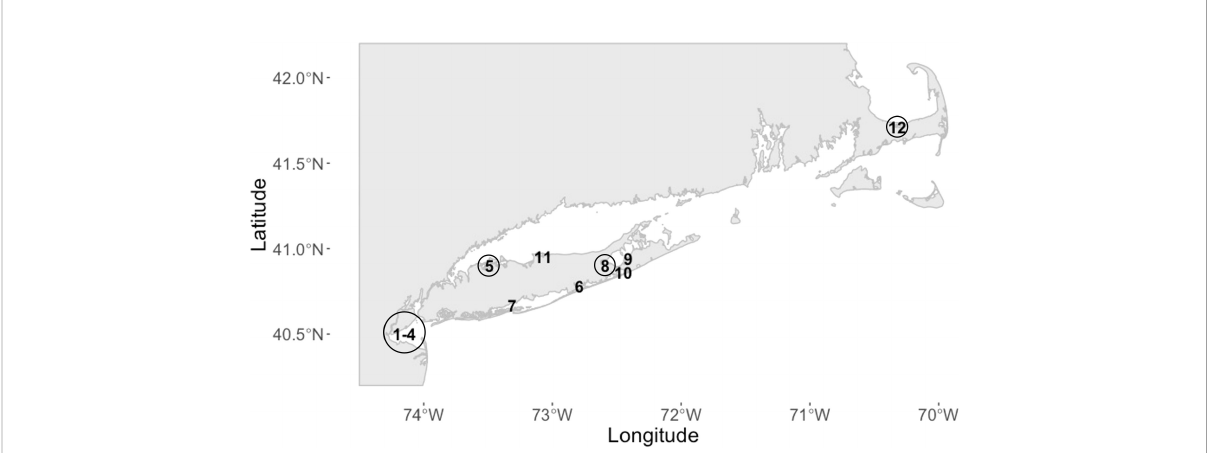
FIGURE 2 Location of sampling sites in Long Island, New York, and Cape Cod, Massachusetts (MA). 1-4 = Raritan Bay (RB), 5 = Oyster Bay (OB), 6 = Moriches Bay (MB), 7 = Babylon Bay (BB), 8 = Birch Creek (BC), 9 = Peconic Estuary (PE), 10 = Shinnecock Bay (SB), 11 = Port Jefferson Harbor (PJ), and 12 = Massachusetts (MA). Sites with a previous history of QPX disease are circled (RB, OB, BC, and MA; circle size is arbitrary). Location coordinates are provided in Supplementary File 2; Table